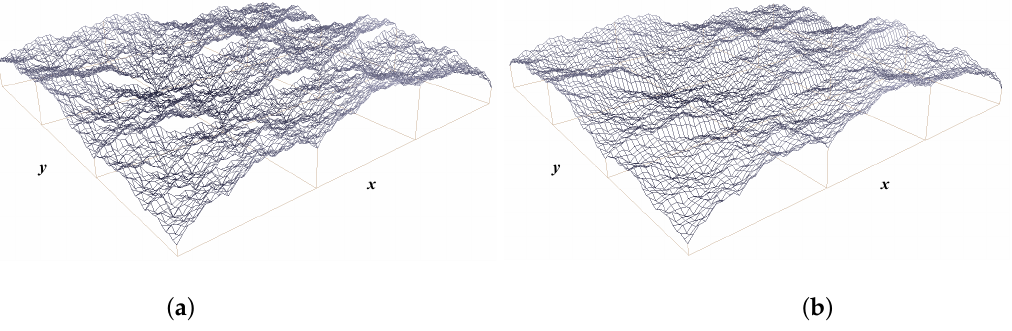
Figure 3. ( a ) The fractal interpolated surface (discontinuous). ( b ) The bivariate fractal interpolation